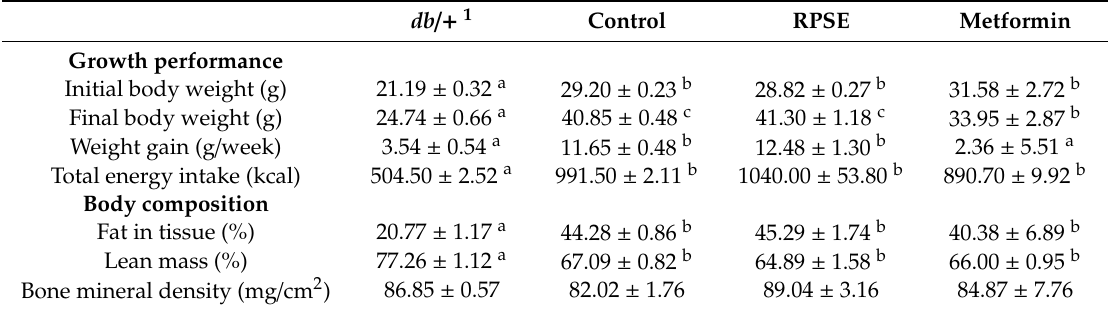
Table 1. Growth performance and body composition of db / db mice supplemented with red pepper seed extract (RPSE).